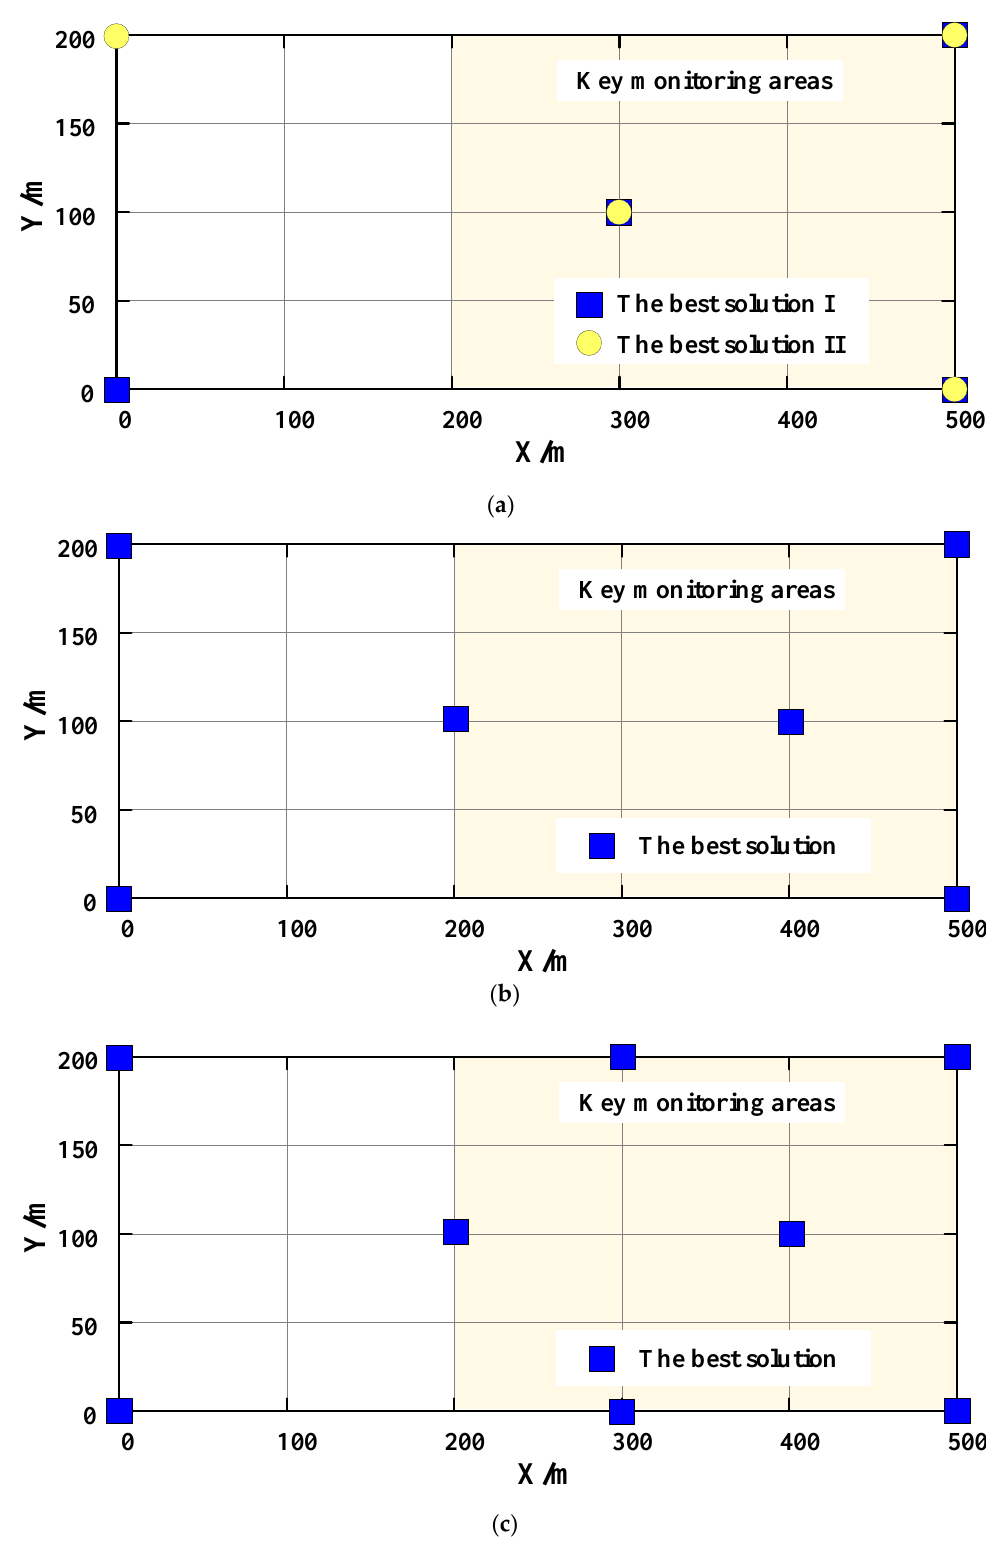
Figure 3. Network configuration results solved by EA. ( a ) Solution Results of Scheme II. ( b ) Solution Results of Scheme II. ( c ) Solution Results of Scheme III.